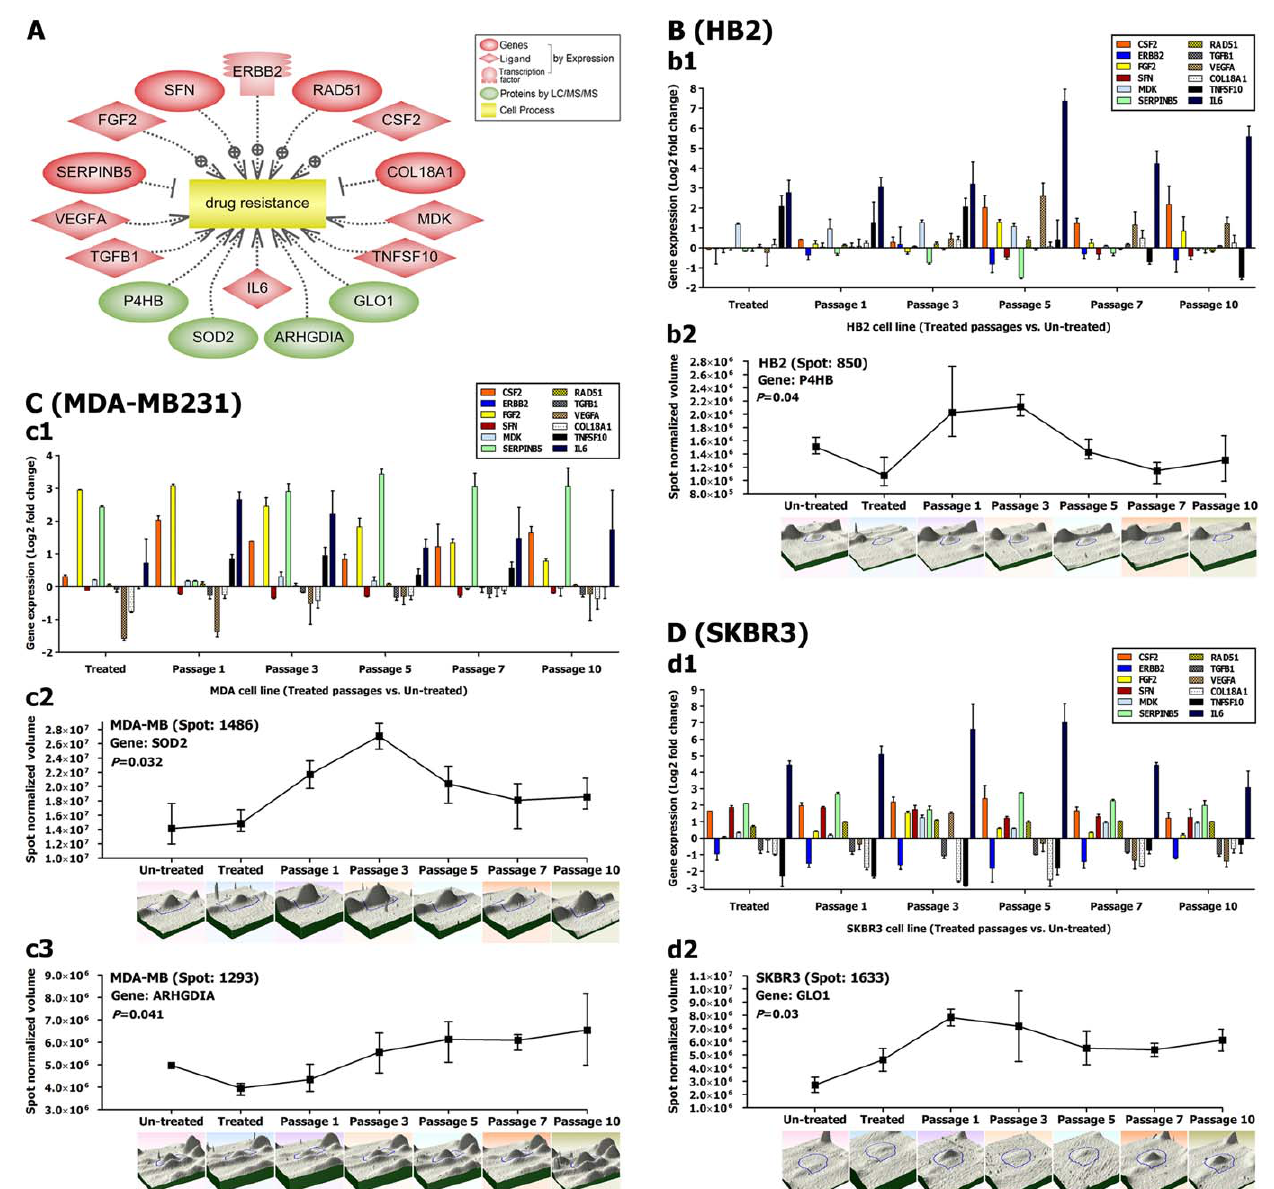
Figure 6. Drug tolerance after treatment with DAC. Candidate genes and proteins that are involved in drug tolerance with significant expression changes after treatment (A). Cell lines: HB2 (B), MDA-MB231 (C) and SKBR3 (D). Expression profiles of 12 candidate genes ( TGFB1 , VEGFA , SERPINB5 , FGF2 , SFN , ERBB2 , RAD51 , CSF2 , COL18A1 , MDK , TNFSF10 and IL6 ) (b1, c1 and d1). Expression profiles of candidate proteins: P4hb (b2), Sod2 (c2), Arhgdia (c3) and Glo1